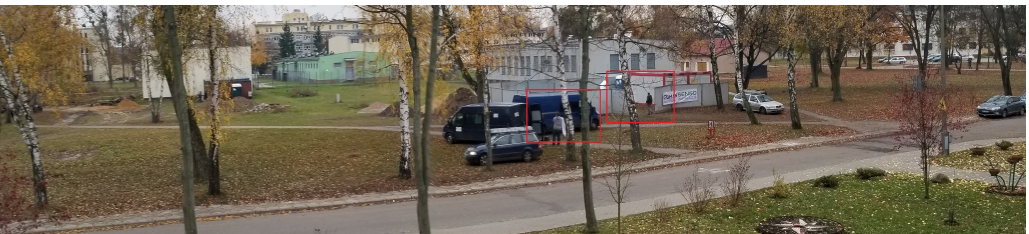
Figure 19. Scan of the Test Area 1.